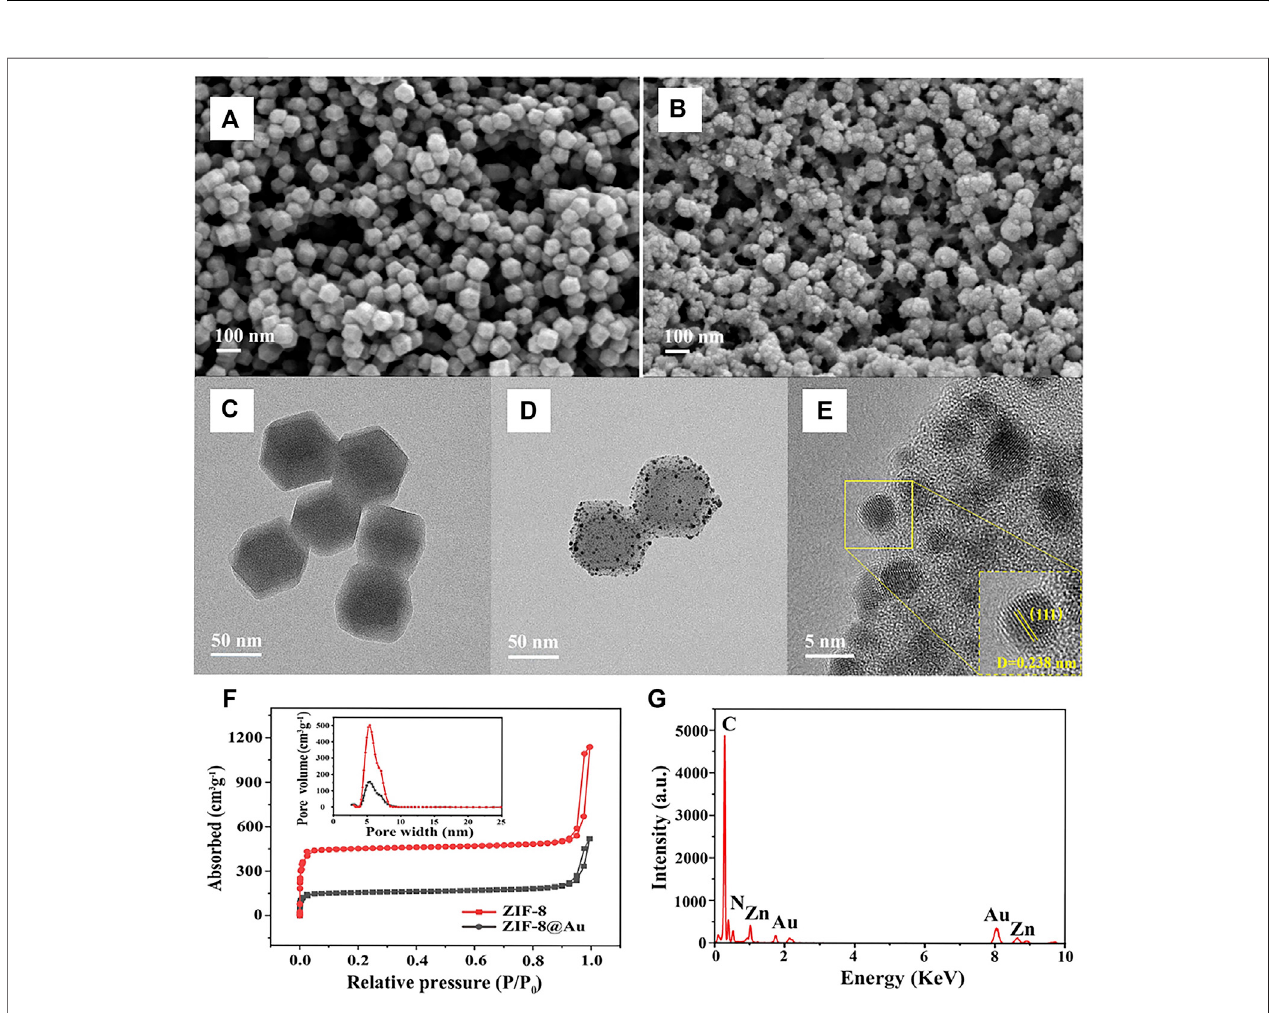
FIGURE 2 | SEM images of (A) ZIF-8 and (B) AuNPs/ZIF-8. TEM images of the (C) ZIF-8 and (D) AuNPs/ZIF-8. (E) HRTEM image of AuNPs/ZIF-8. (F) N 2 adsorption – desorption isotherms of ZIF-8 and AuNPs/ZIF-8 (inset: pore size distribution). (G) EDS spectrum of AuNPs/ZIF-8.